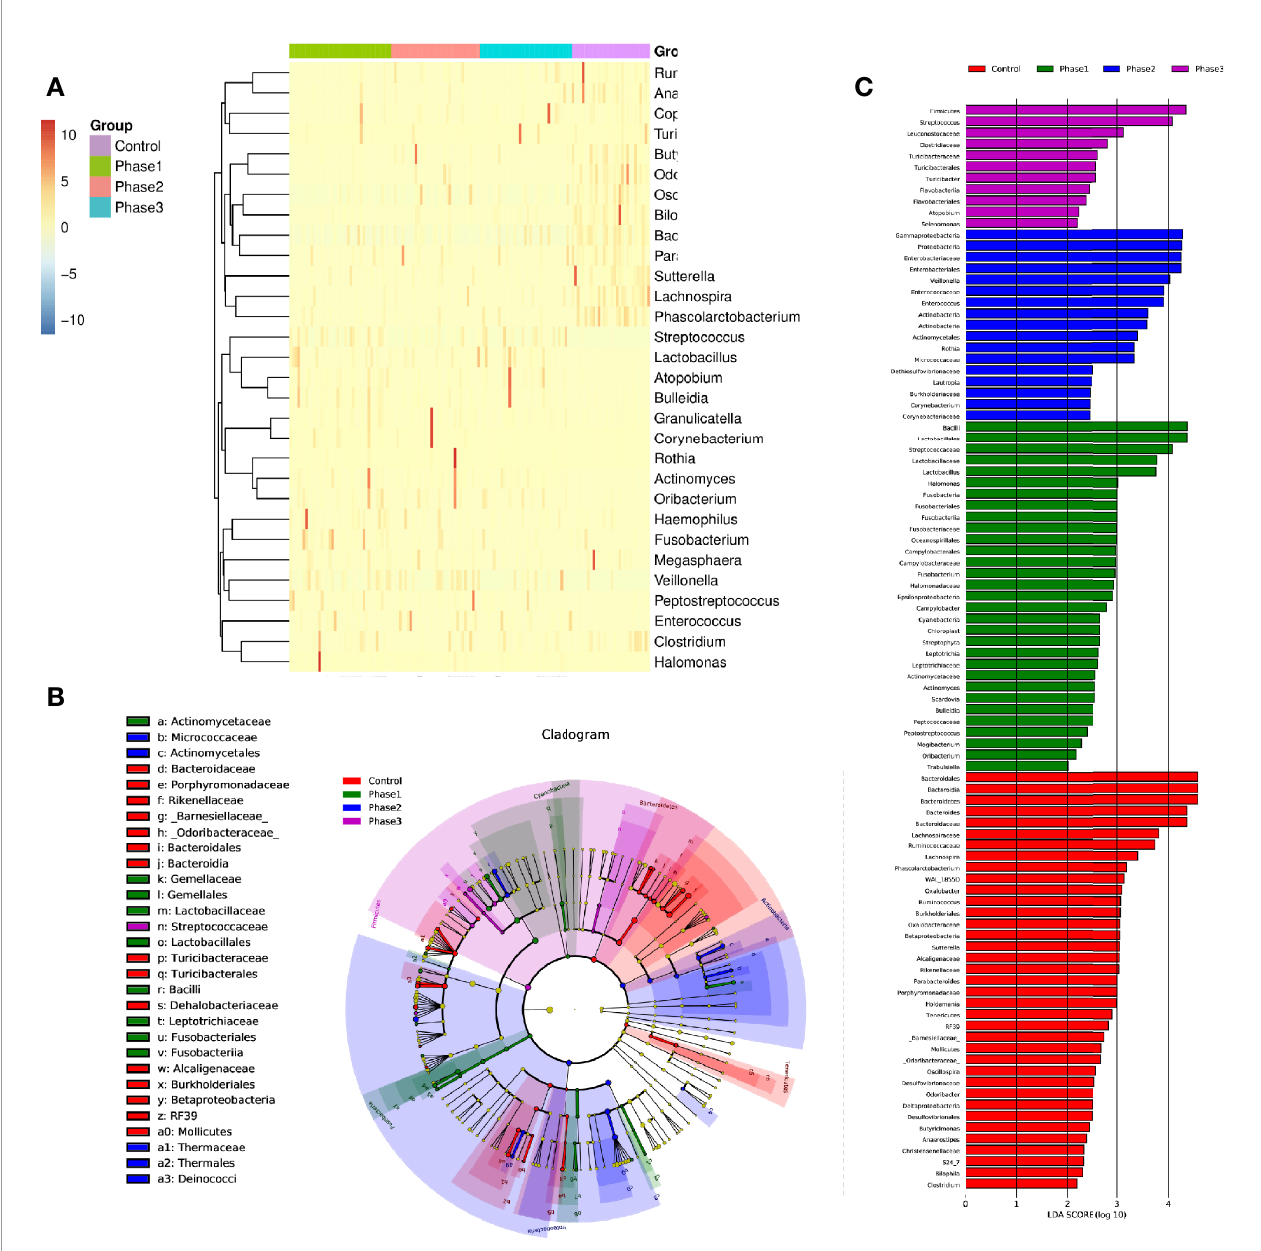
FIGURE 3 | The statistically signi fi cant microbial communities associated with the HBV-ACLF. (A) Heatmap of 32 statistically signi fi cant genera. (B) Cladogram indicated the phylogenetic distribution of microbial communities associated with the three phases and the HC group; lineages with LDA values of 3.0 or higher as determined by LEfSE are shown. LEfSe (LDA Effect Size) analysis was performed to fi nd biomarkers with signi fi cant differences (p < 0.05) between different groups. Differences are represented by the color of the most abundant class. Green sample indicates Phase 1, blue sample indicates Phase 2, purple sample indicates Phase 3, and red represents HC group. (C) Indicator microbial groups in the four groups with LDA scores higher than 3.0. The bar length is proportional to the LD score that indicates the signi fi cance of the genus. Differences are represented by the color of the most abundant class. Green sample indicates Phase 1, blue sample indicates Phase 2, purple sample indicates Phase 3, and red represents HC